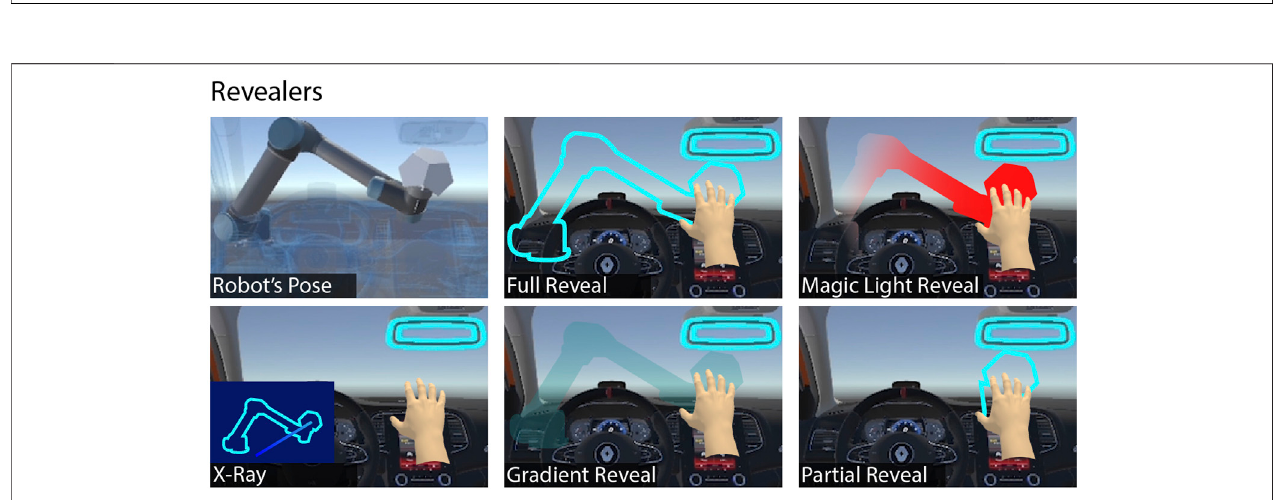
FIGURE 2 | The revealers group. This group comprises techniques that display the ETHD ’ s virtual counterpart in the virtual environment.